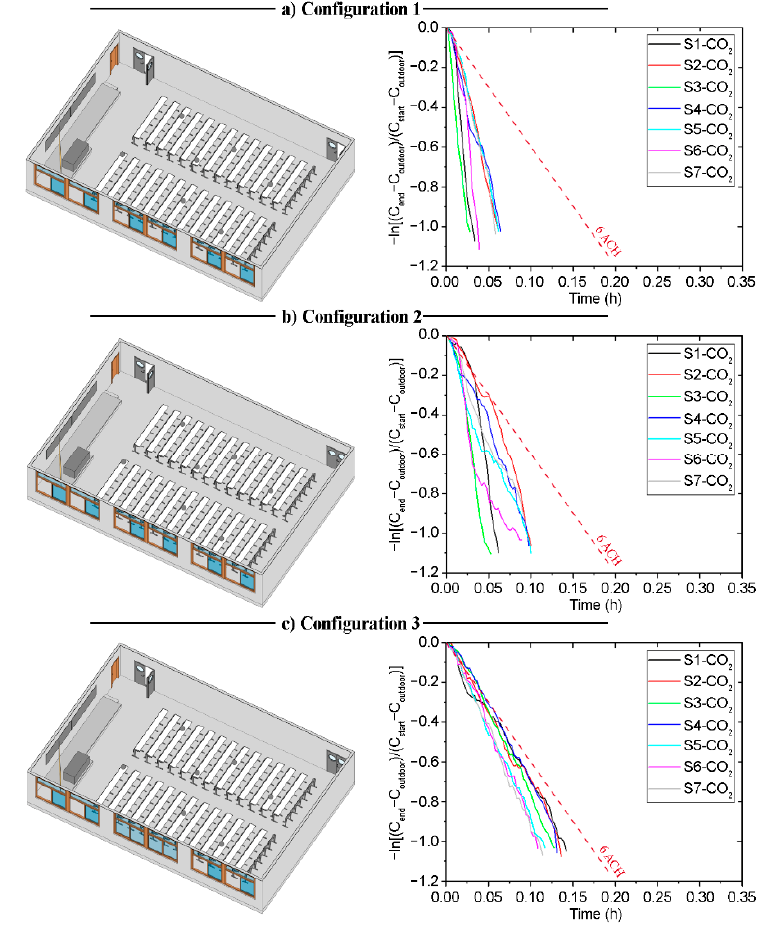
Figure 9. Configuration schemes and decay curves in Classroom B2-A1. ; ( a ) Configuration 1; ( b ) Configuration 2; ( c ) Configuration 3.